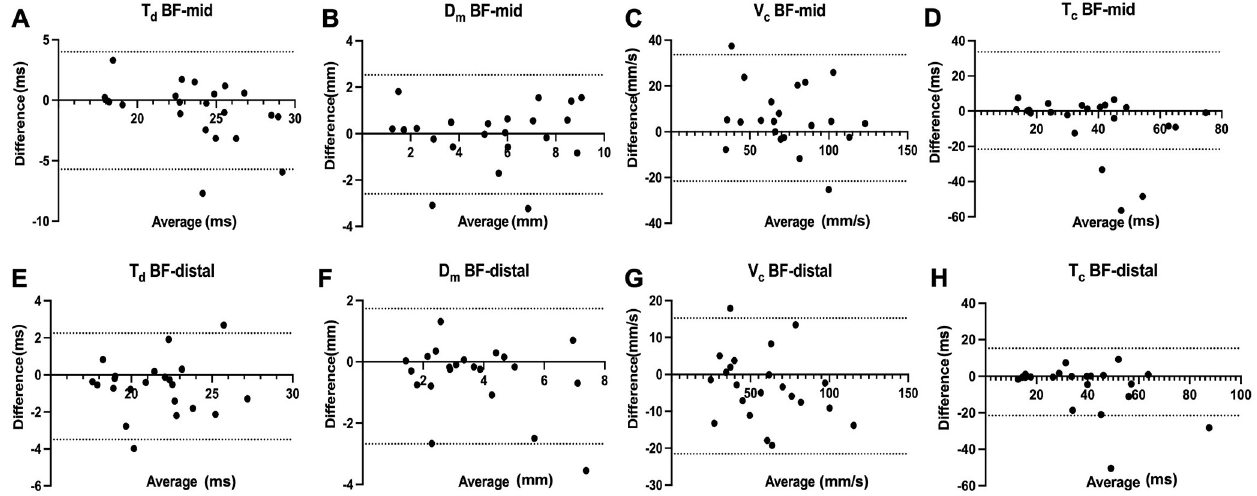
Fig 2. Limits of agreement analysis between the fixed and non-fixed conditions across the TMG-derived parameters. A = T d at BF-mid, B = D m at BF- mid, C = V c at BF-mid, D = T c at BF-mid, E = T d at BF-distal, F = D m at BF-distal, G = V c at BF-distal, H = T c at BF-distal.